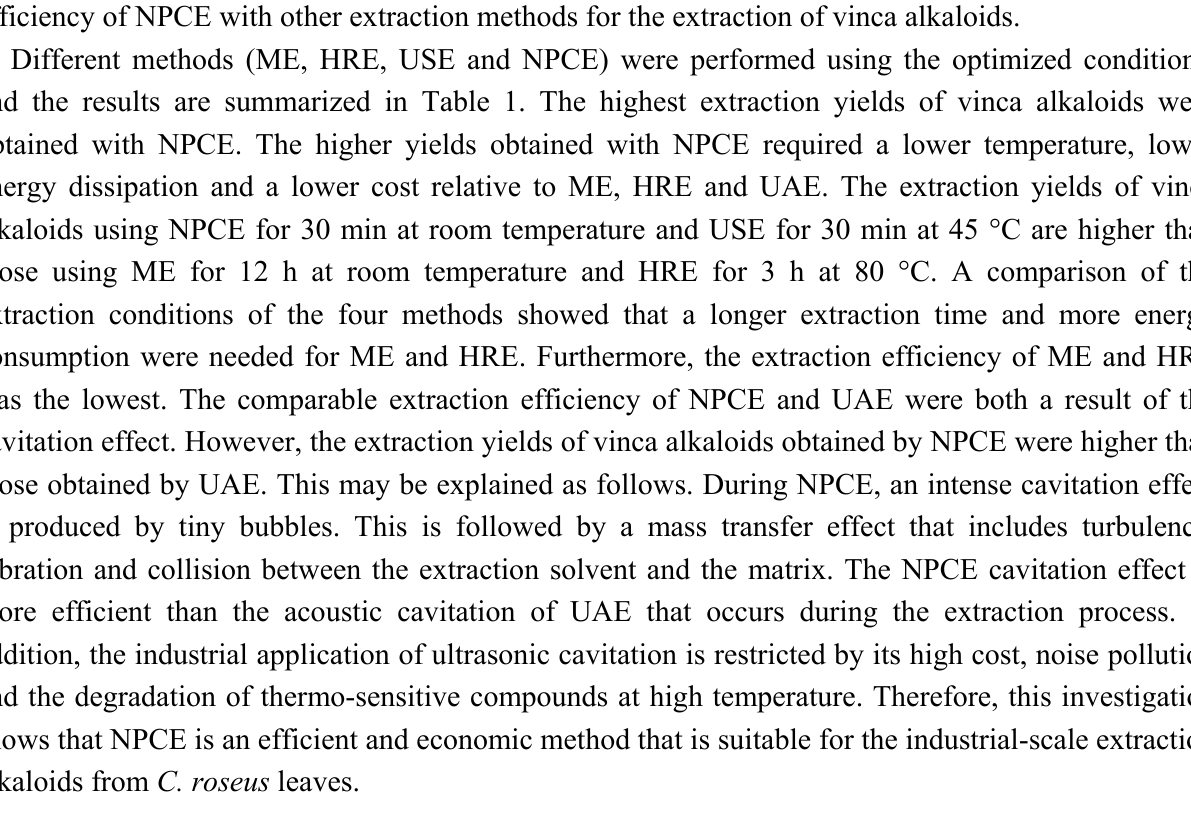
Table 1. Comparison of ME, HRE, UAE and NPCE on the yields of VDL, CTR, VCR and VLB from C. roseus leaves. Data are presented as means ± S.D. ( n =